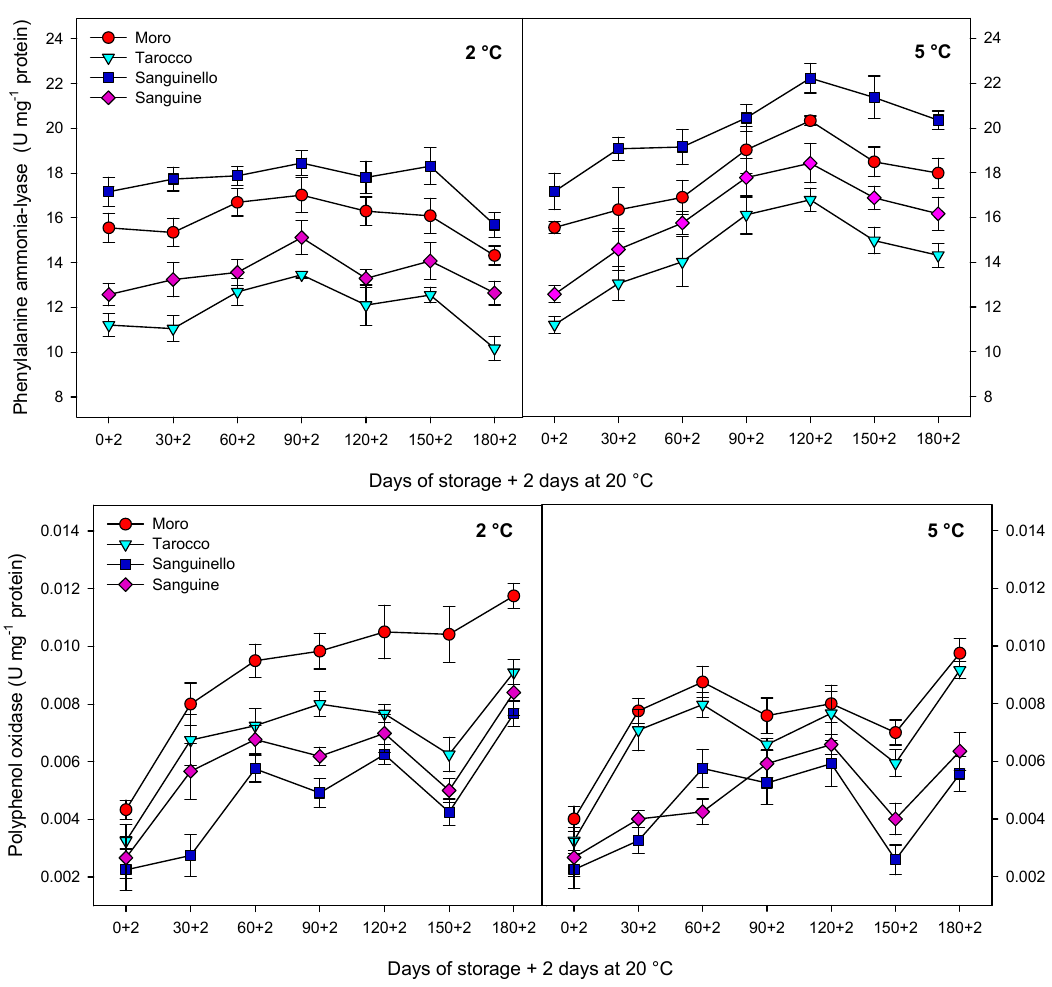
Figure 6. Changes in phenylalanine ammonia-lyase (PAL) and polyphenol oxidase (PPO) enzyme activities of blood orange cultivars (“Moro”, “Tarocco”, “Sanguinello”, and “Sanguine”) stored at 2 and 5 °C for 180 days plus 2 days at 20 °C. Vertical bars represent ± standard error (SE) of means. LSD ( p < 0.05) values are 1.91 and 0.005 for PAL and PPO, respectively.